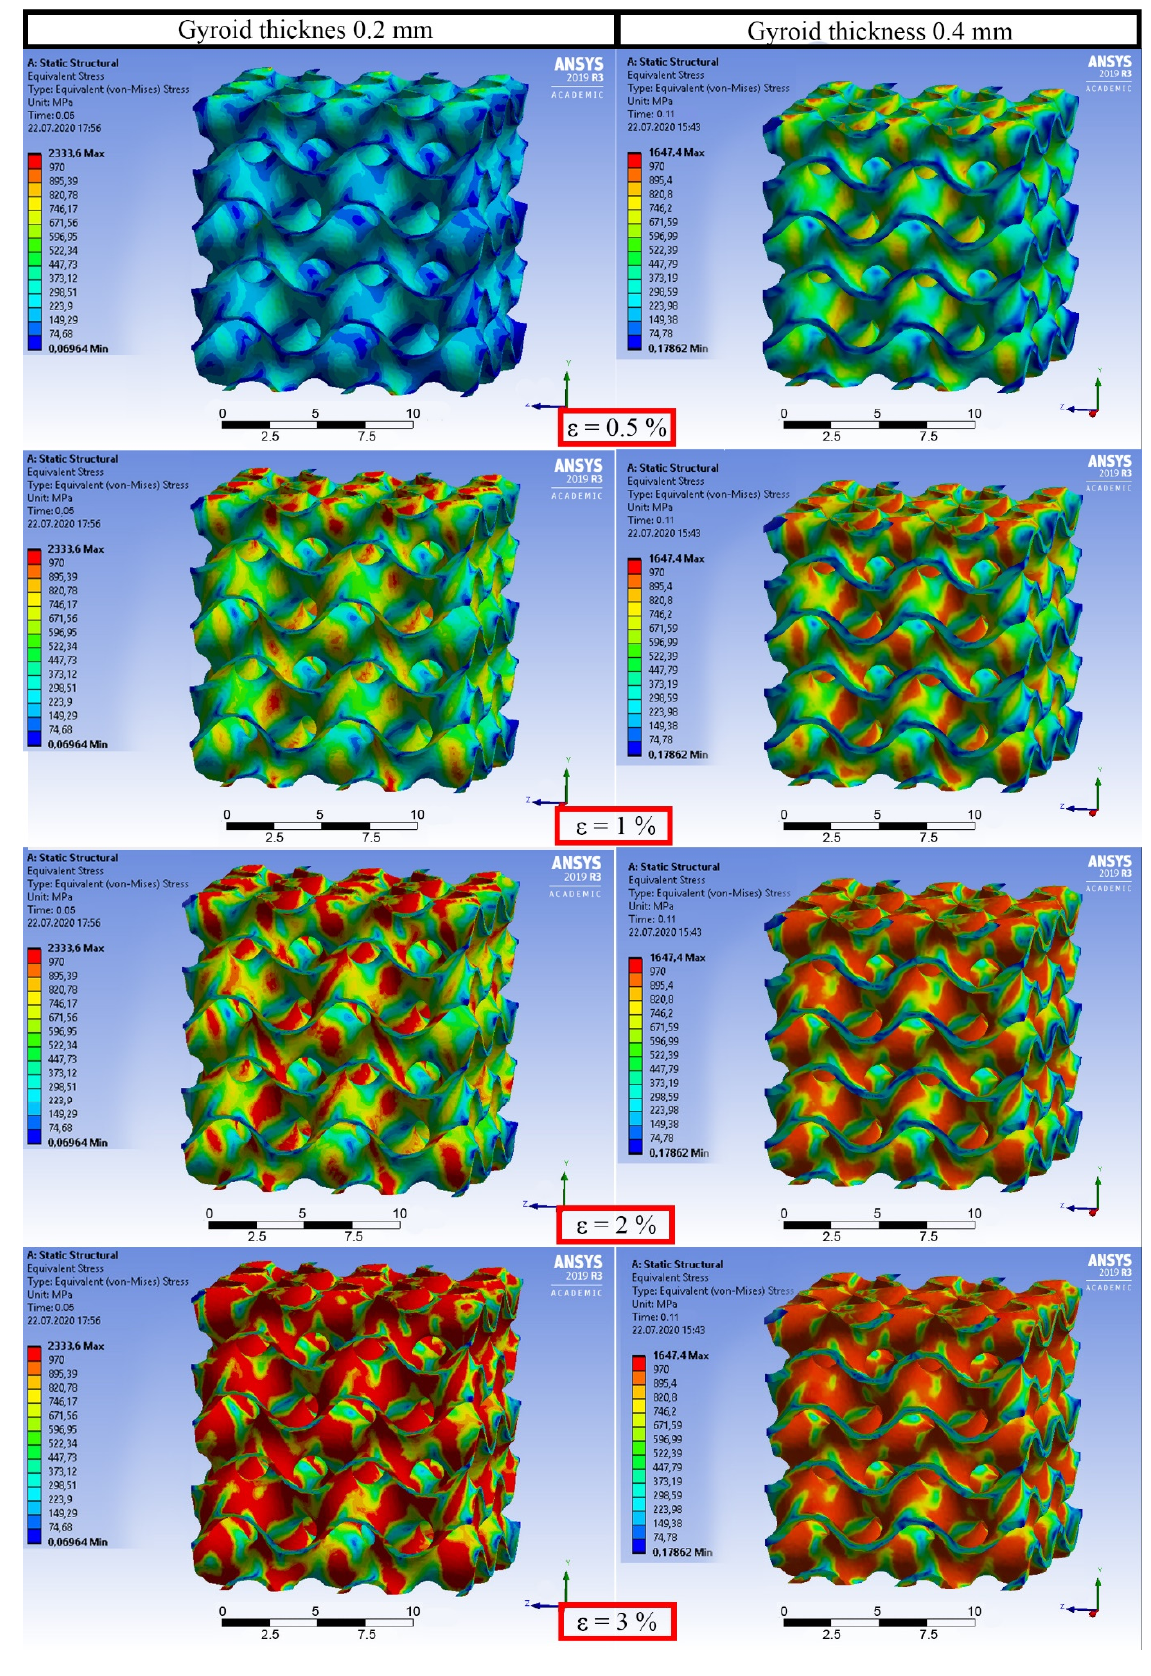
Figure 9. Simulations of the stress distribution during uniaxial tension (elastic region) of the gyroids with different thicknesses.